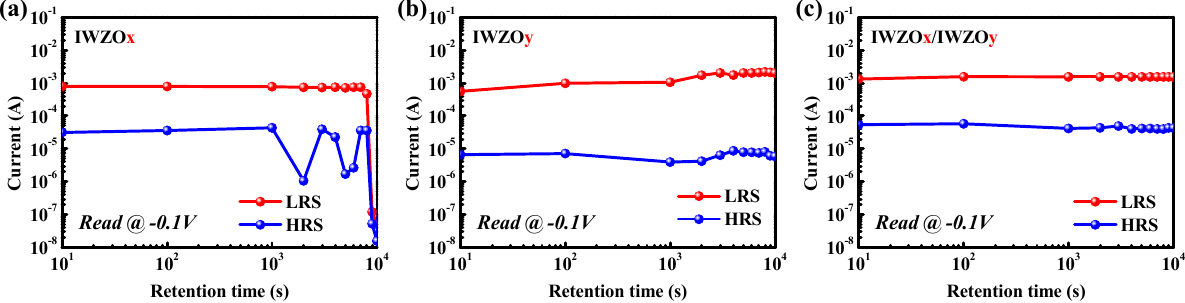
Figure 7. This data retention time of CBRAM devices with ( a ) IWZOx, ( b ) IWZOy, and ( c ) IWZOx/IWZOy switching layer operated at 85 ° C.